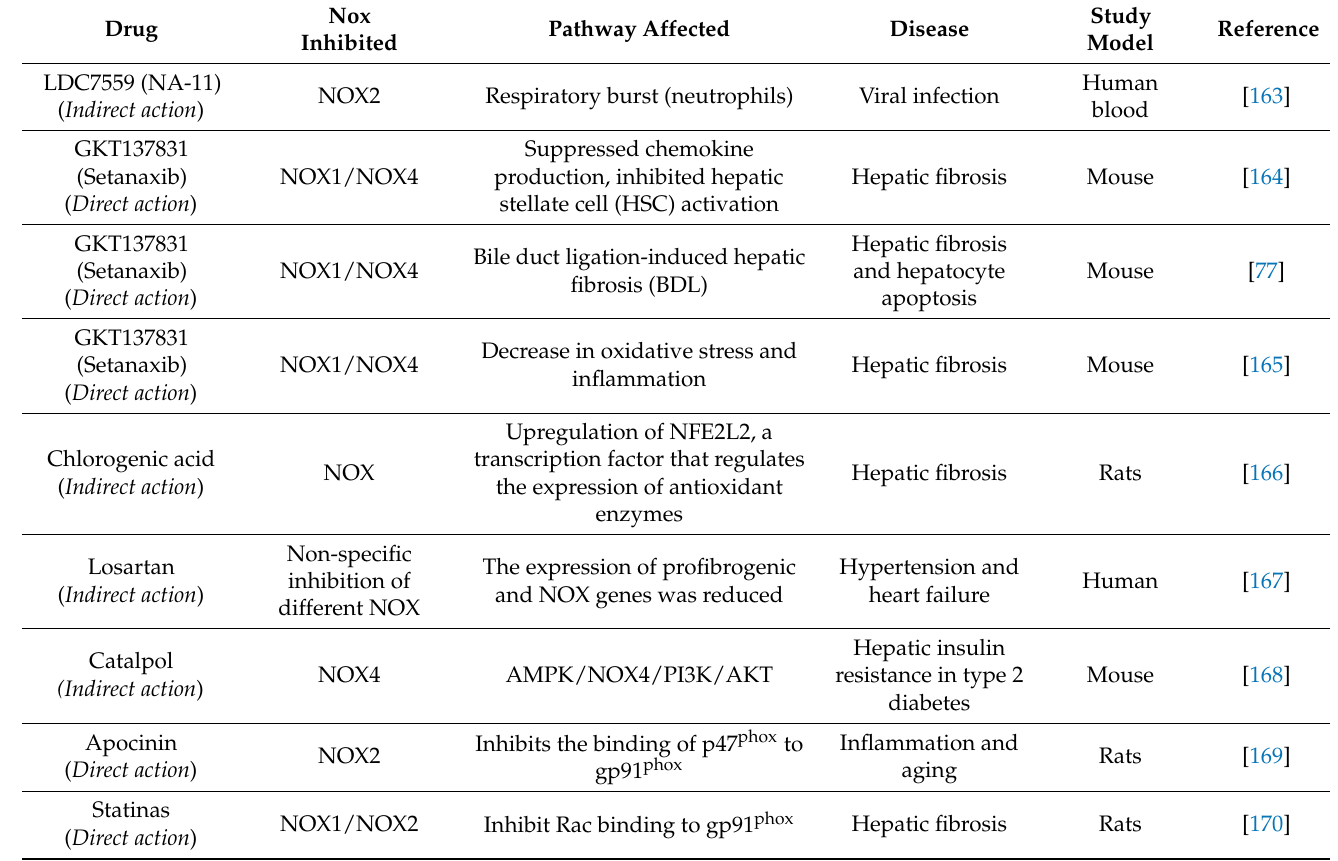
Table 1. Some examples of drugs used to inhibit the activity of NOX in liver